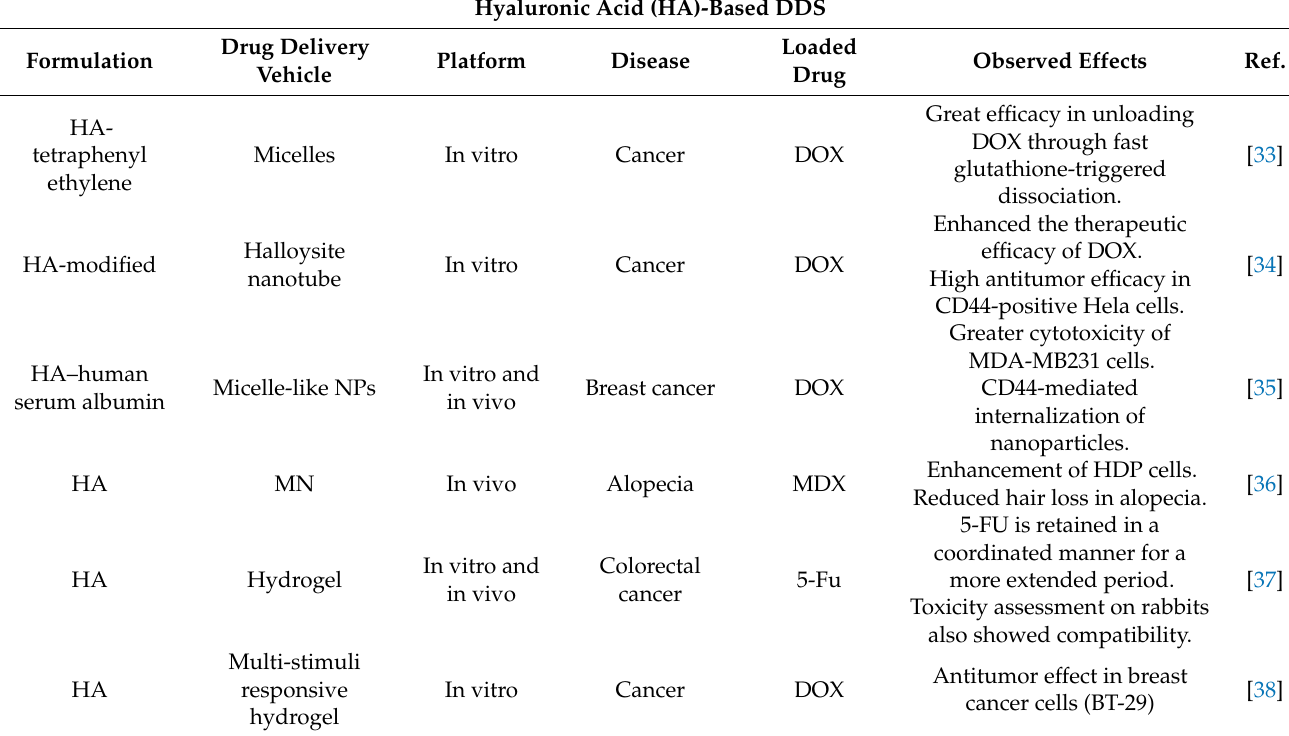
Table 2. Summary of studies on HA-based